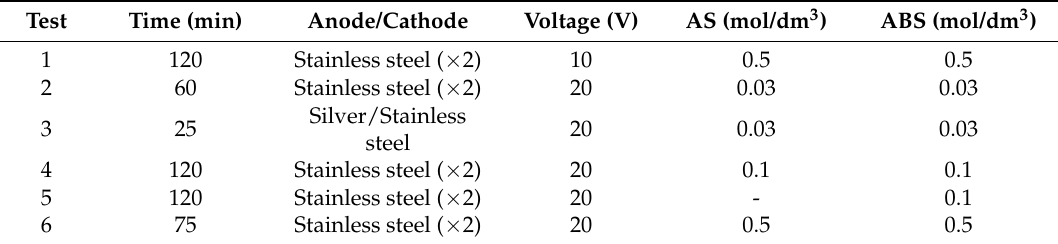
Table 2. Summary of the variation of experimental start parameters.